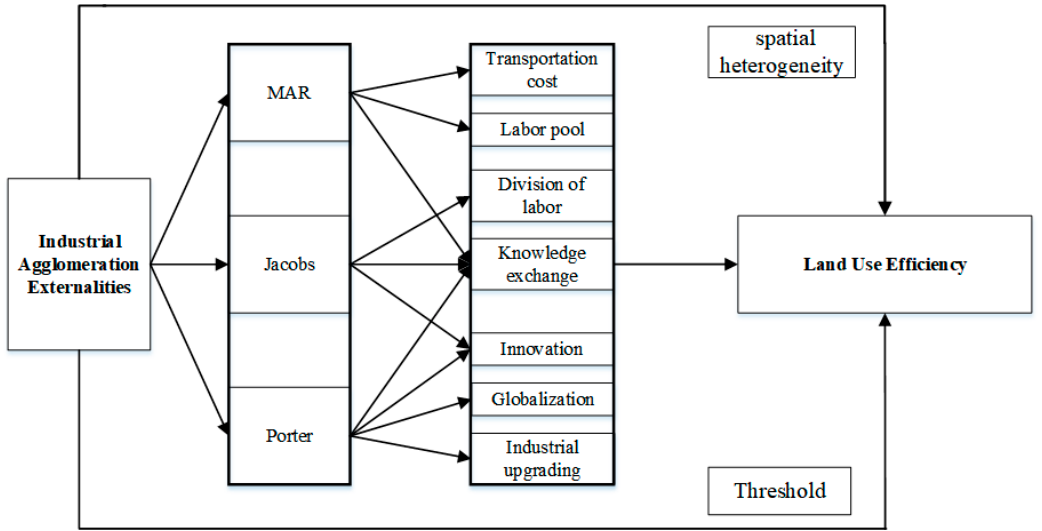
Figure 1. Theoretical framework of Industrial Agglomeration Externalities affecting ULUE.